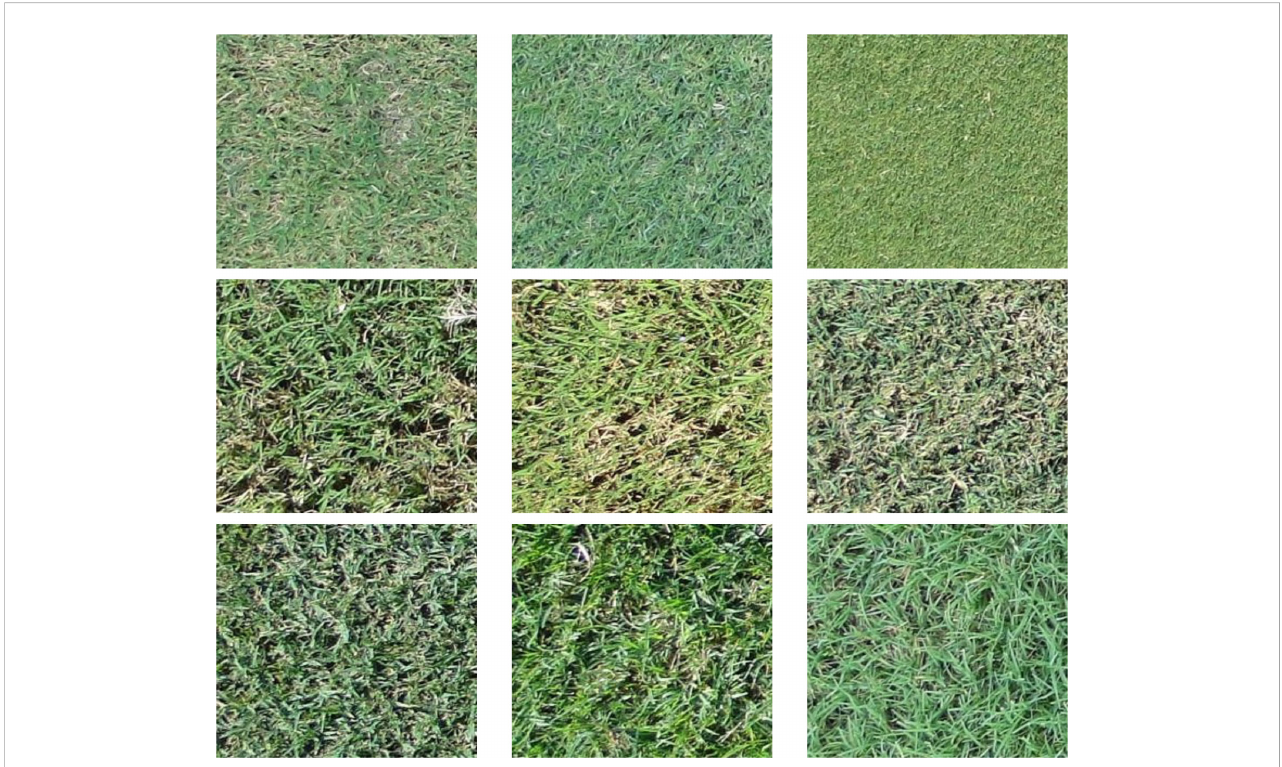
FIGURE 4 The training and testing sub-images of bermudagrass at different turfgrass management regimes, mowing heights, and surface conditions.